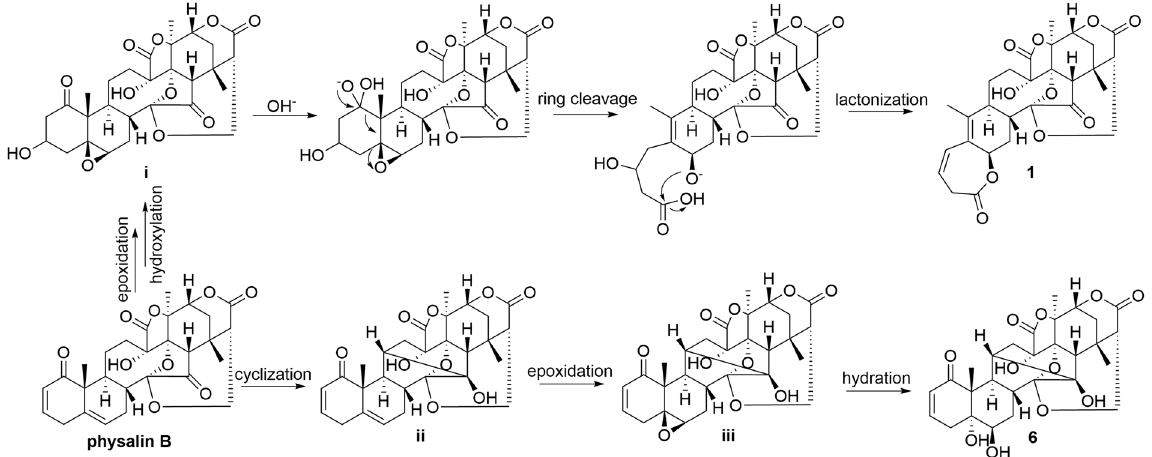
Figure 5. A plausible biogenetic pathway for compounds 1 and 6